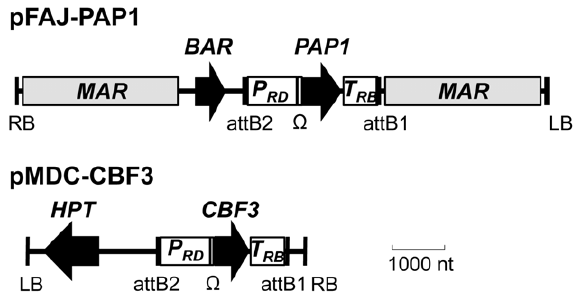
Figure 1. Schematic illustrations of transgene expression cassettes in pFAJ-PAP1 and pMDC-CBF3. P RD ; Arabidopsis RD29a promoter, V ; tobacco mosaic virus omega sequence, BAR; BASTA resistance gene, HPT; hygromycin phosphotransferase, MAR; chicken matrix attachment region, attB; gateway recombination sites, LB; T-DNA left border, RB; T-DNA right border, T RB ; soybean Ribulose-1,5-bispho- sphate carboxylase oxygenase terminator.